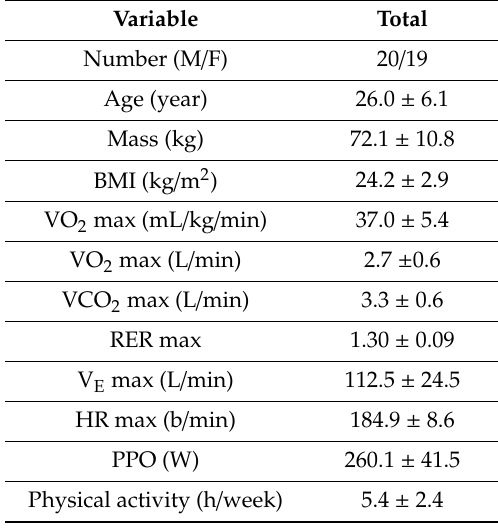
Table 1. Physical characteristics of participants, including maximal gas exchange data (mean ±